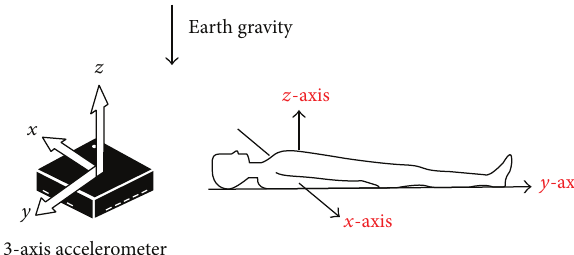
Figure 1: Direction of the detected accelerations from the